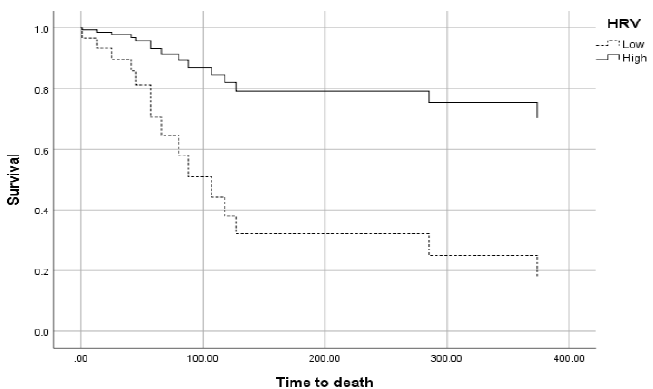
Figure 1. The relationship between HRV and overall survival in RR ‐ DLBCL.